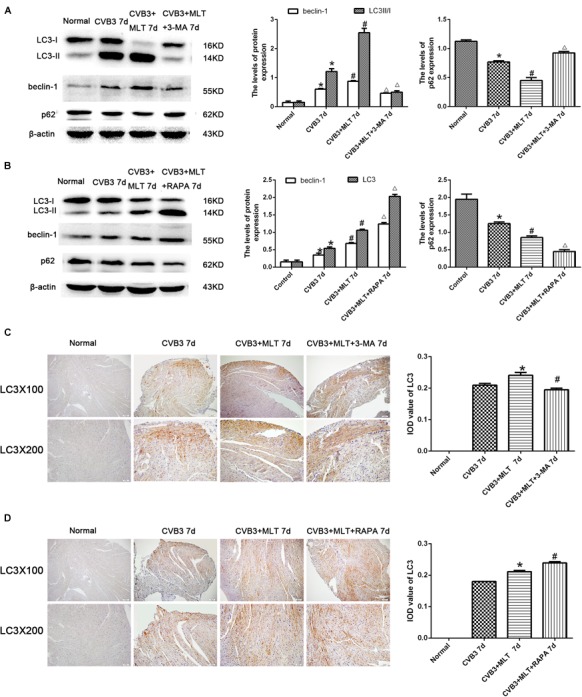
Levels of autophagy in the heart on day 7 (n = 5 in each group). (A,B) Expression of autophagy-related proteins in the myocardial tissues of mice in four groups on day 7. (C,D) Immunohistochemistry for LC3 on day 7. ∗P < 0.05 versus the normal group, #P < 0.05 versus the CVB3 group, ∆P < 0.05 versus the CVB3 + MLT group.